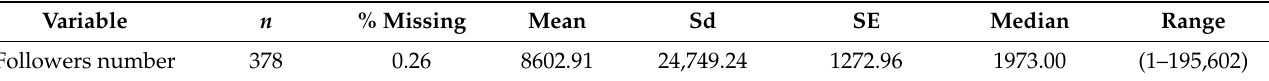
Table 5. Descriptive statistics of the distribution of